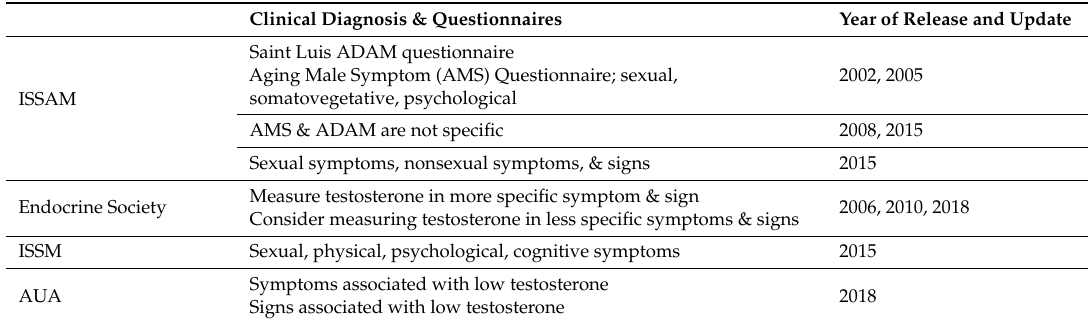
Table 3. Evolution of clinical diagnosis and